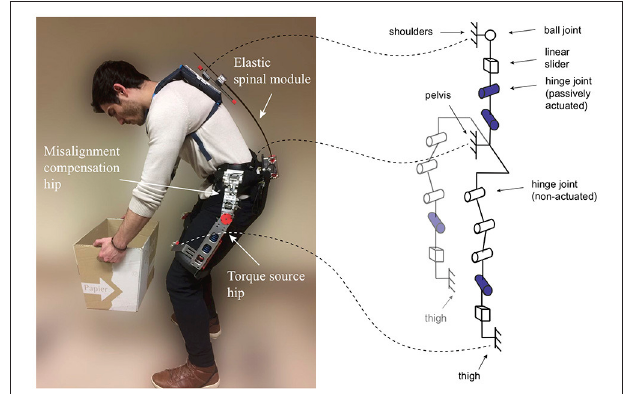
FIGURE 4 | (Left) Passive Spexor prototype. An elastic spinal module in the back is used to provide a large range of motion and to store energy. Several misalignment compensating mechanisms at the hip and the back (hip indicated in the figure) are implemented. A passive, parallel elastic torque source provides support at the hip; (Right) Kinematic equivalent representation. The spinal structure is comprised of a ball joint and a linear slider in combination with elastic beams (here represented as two hinge joints in series). This structure provides flexibility and compensates for potential misalignment. The hip structure consists of three parallel hinge joints in combination with a fourth, actuated hinge joint in series with a linear joint. This structure fulfills a dual function, once as a fitting mechanism and once as a misalignment compensating structure. Written informed consent was obtained from the participant to publish this